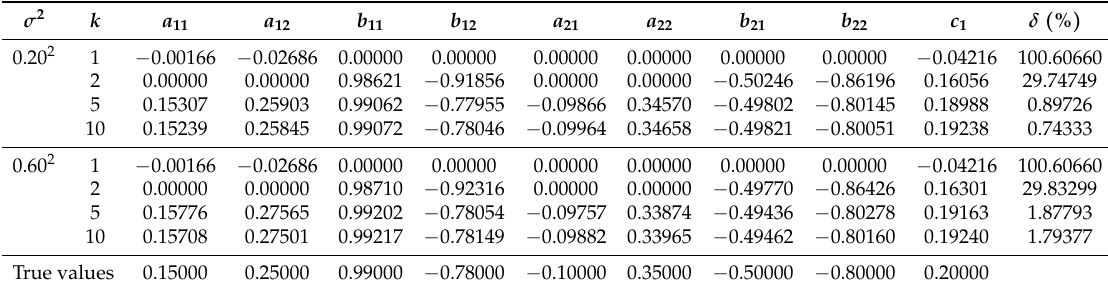
Table 3. The F-LSI parameter estimates and errors for Example 1 ( L = 4000).